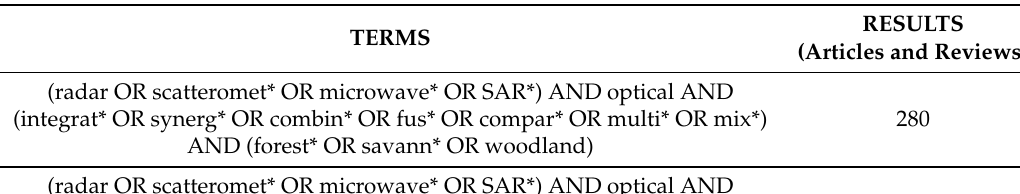
Table 1. Search terms used to select studies for review and the initial number of results for each search